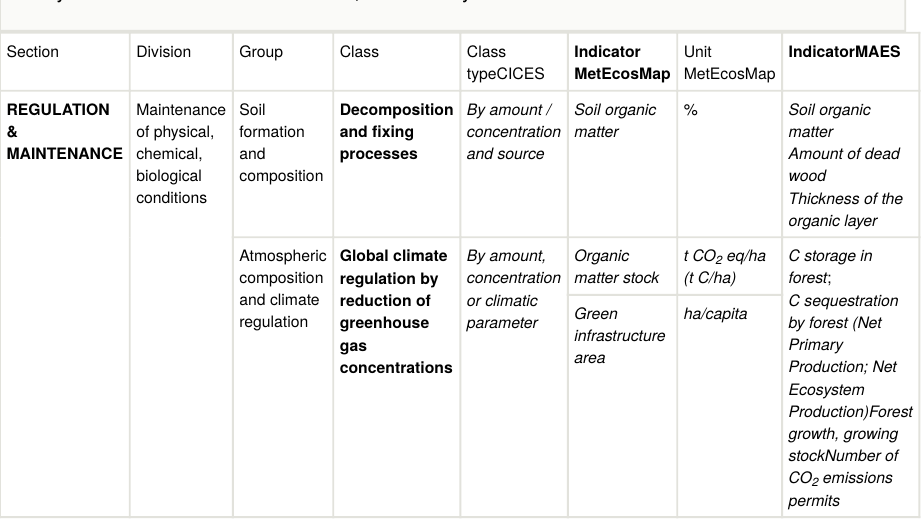
Ecosystem services from CICES V 4-3, identi fi ed by the selected